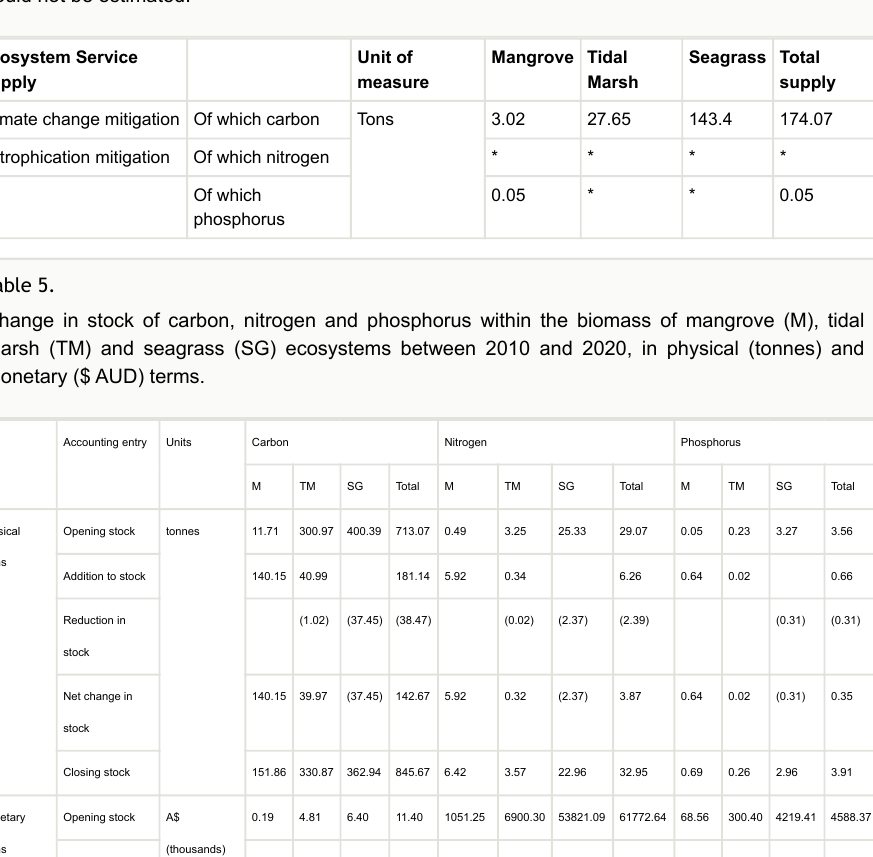
could not be estimated.